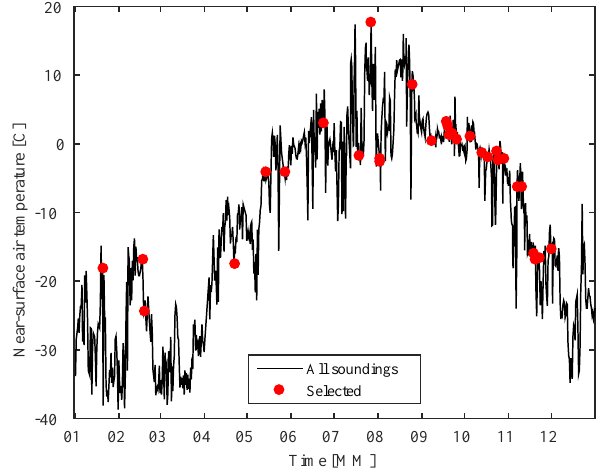
Figure 1. Temperature time series for the lowest level of each ra- diosonde from the 2012 Barrow data set. Red dots represent the 30 radiosondes that were selected for the data